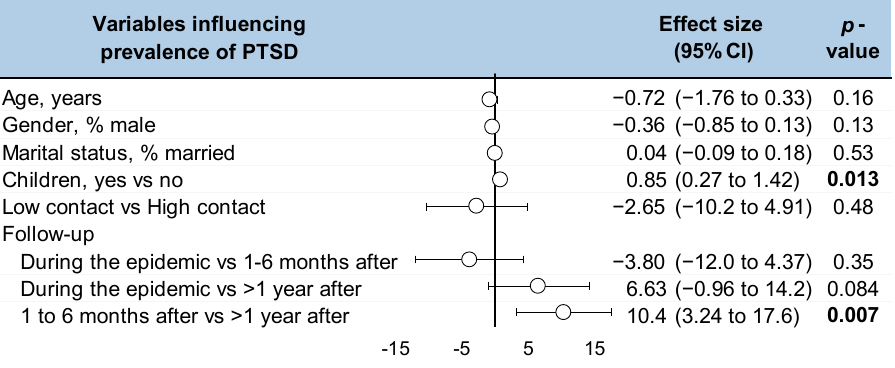
Figure 5. Factors influencing (meta-regressions) the prevalence of post-traumatic stress disorder following the SARS-CoV-1 epidemic of 2003. Each summary of meta-analysis is represented in the forest-plot by a white circle (dot) on a horizontal line.